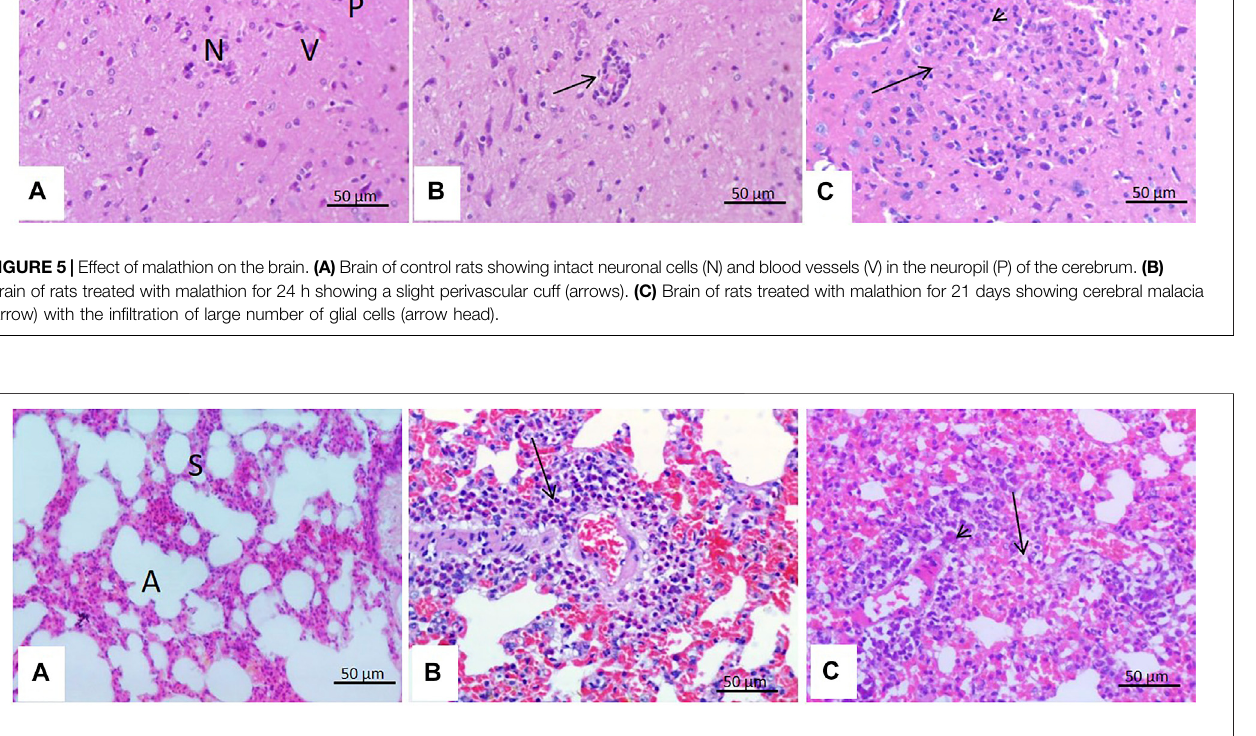
FIGURE6 | Effectof malathion on the lungs. (A) Lungs ofcontrol ratswithclear and intact alveoli (A) with thin inter-alveolar septa (S). (B) Lungsof rats treated with malathion for 24 h showing congestion of the inter-alveolar blood vessels and perivascular eosinophilic in fi ltration (arrow). (C) Lungs of rats treated with malathion for 21 days showing thickening of the inter-alveolar septa in fi ltration of a large number of mononuclear in fl ammatory cells (arrow).